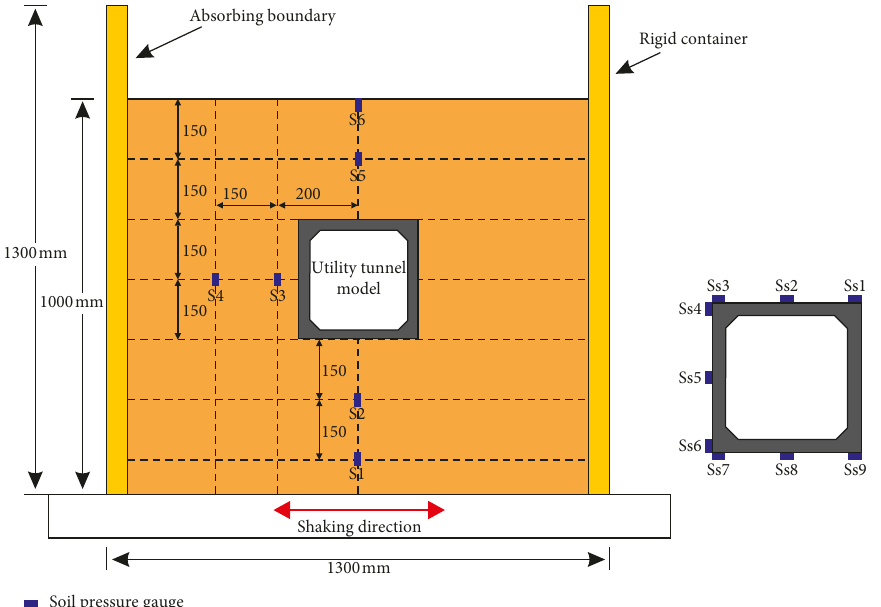
Figure 5: Arrangement of soil pressure gauge embedded in the soil and